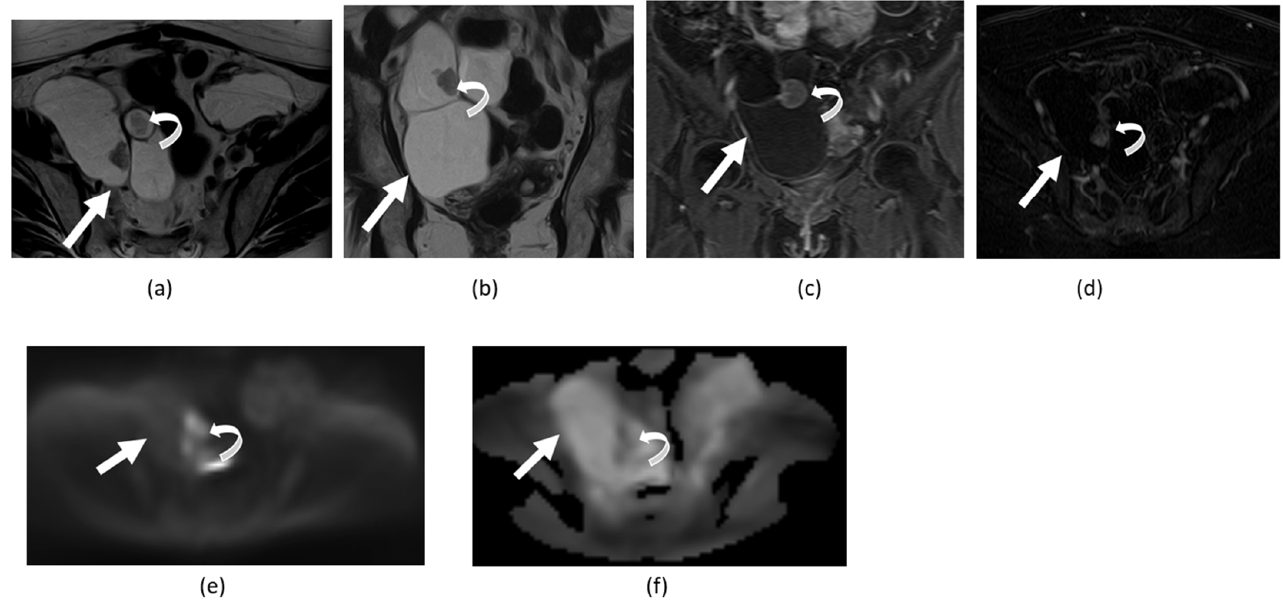
Figure 16. Axial ( a ) and coronal ( b ) T2-weighted images and contrast-enhanced fat-suppressed T1- weighted coronal image ( c ) and axial contrast-enhanced fat-suppressed T1-weighted with subtraction ( d ) show a large multiloculated ovarian mass (straight arrows) with solid component characterized by papillary projections and mural nodules (curved arrows) demonstrating diffusion restriction on DWI ( e ) and ADC maps ( f ). The lesion was pathologically proven to be a cystic ovarian cystadenocarcinoma.